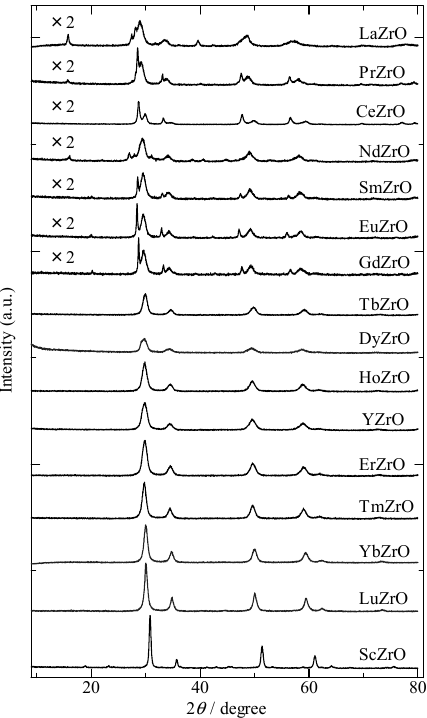
Figure 2. XRD patterns of REZrO samples calcined at 900 °C.